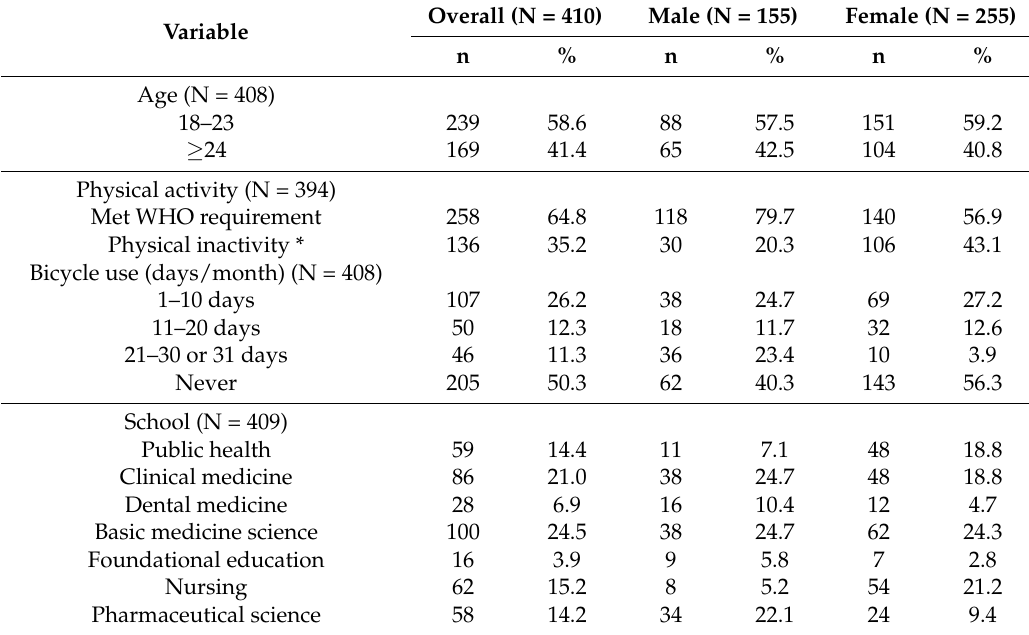
Table 1. Overall and gender-specific characteristics among